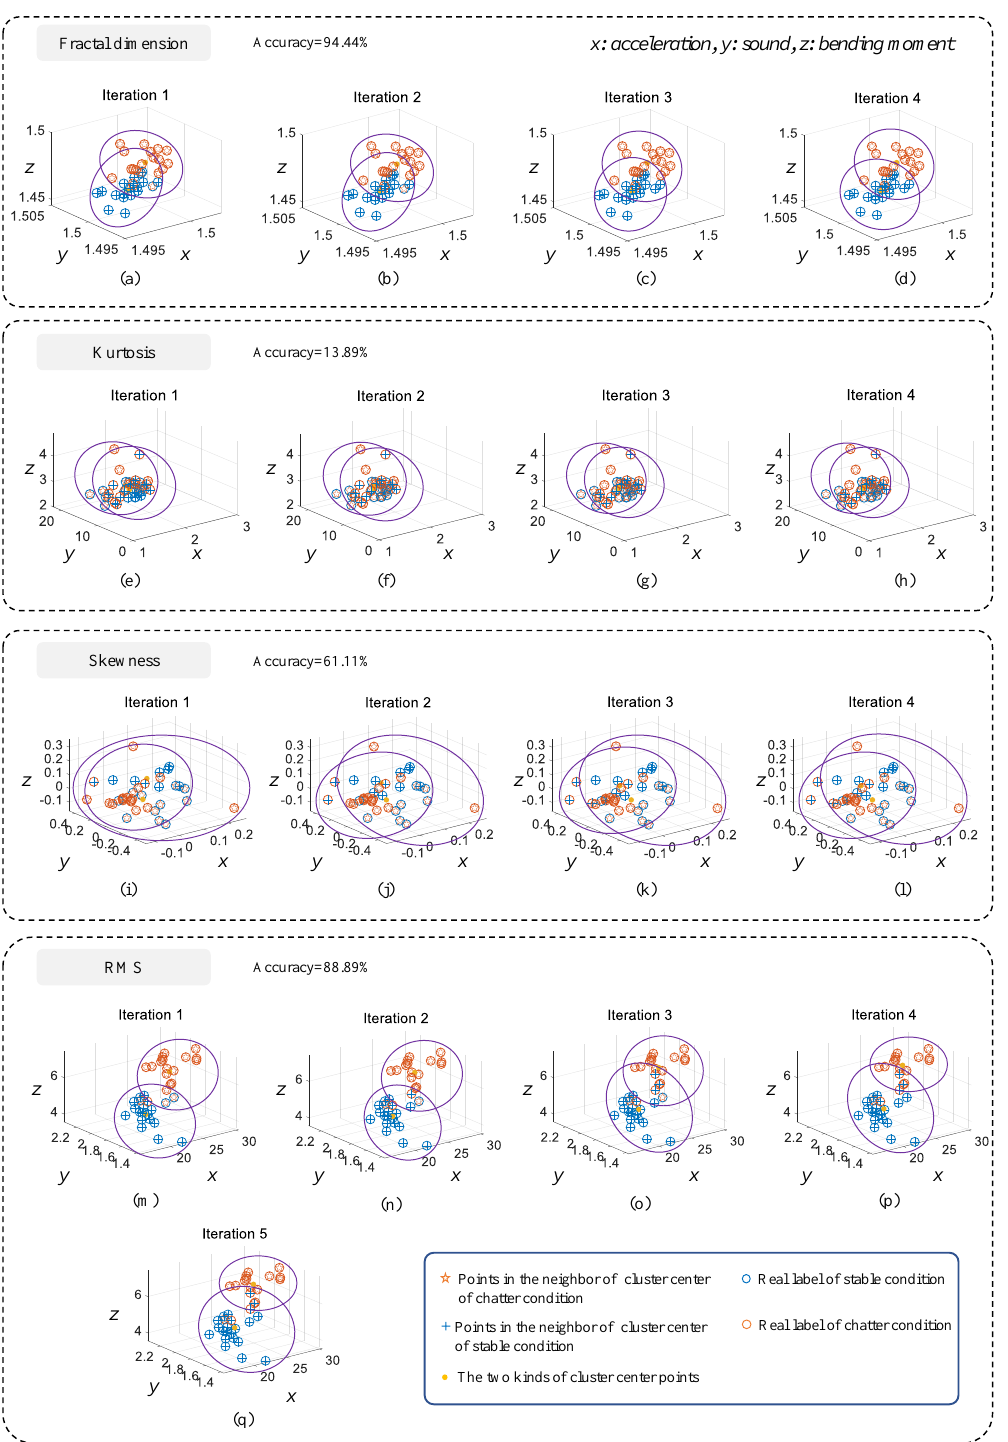
Figure 6. Iteration results.